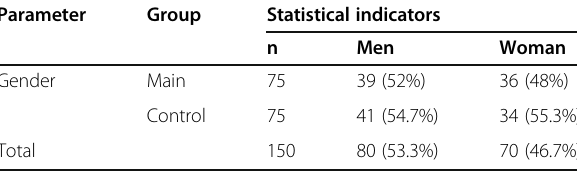
Table 3 Allocation of patients according to